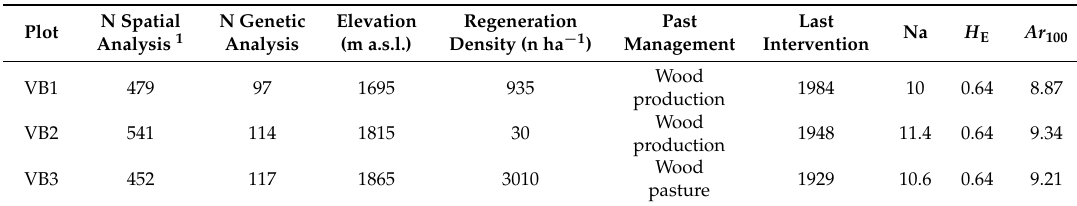
Table 1. Characteristics of the three 1-ha stands investigated and genetic parameters estimated on the subsamples of individuals for genetic